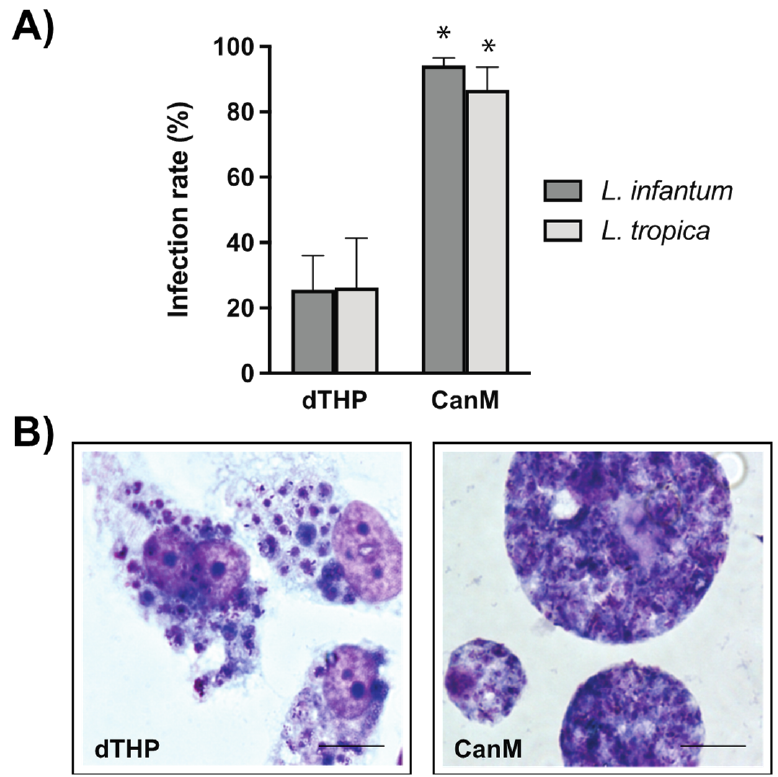
Figure 3. Comparative parasite infection of human vs. canine macrophages. ( A ) Percentage of infected dTHP-1 or canine macrophages (CanM) with L. infantum and L. tropica promastigotes. Infected cells were Giemsa stained and the percentage of infected cells was calculated. Data are the mean of IC 50 (µM) ± SD of at least four different experiments in duplicate. Significant differences were found between the infection rates of human and canine macrophages with L. infantum and L. tropica (* p < 0.05, two-way ANOVA and Sidak’s multiple comparison test). ( B ) Selected images of Giemsa-stained dTHP-1 and CanM containing L. infantum amastigotes.